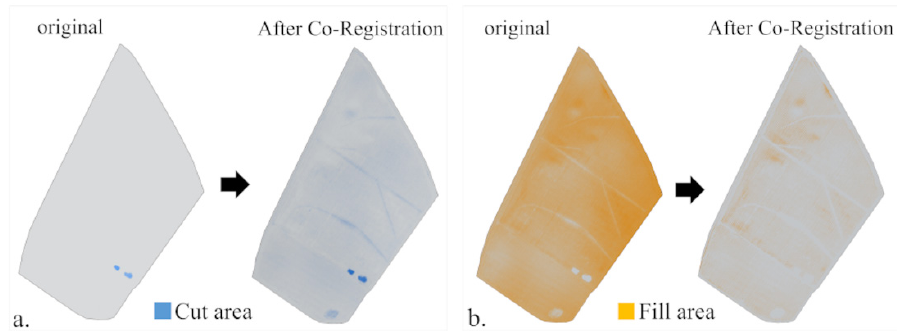
Figure 17. Fill and cut areas estimation, without and with DTM co-registration; ( a ) negative elevation difference values or cut areas; and ( b ) positive elevation difference values, the soil has been “filled in”. Table 10. Fill and cut volumes and change volume for the different differential DTM scenarios: First